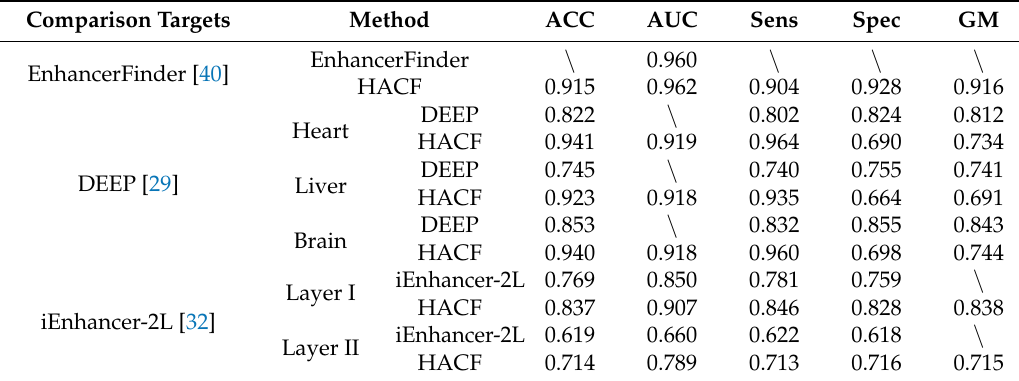
Table 2. Comprehensive comparisons with three existing enhancer prediction